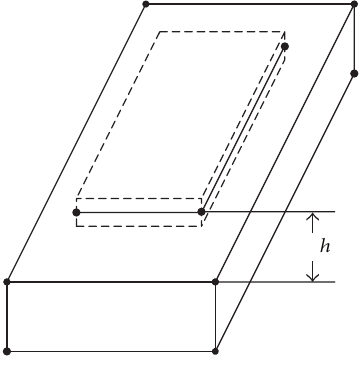
Figure 6: Shell-solid